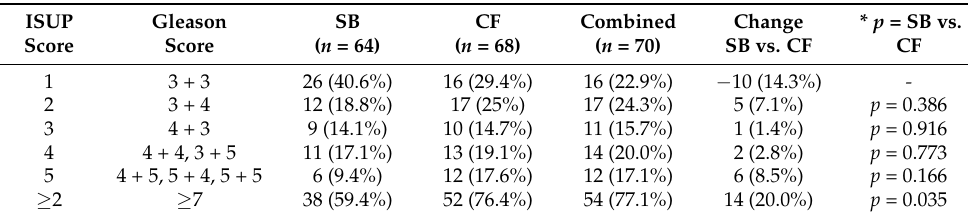
Table 1. Pathological ISUP and Gleason scores for patients diagnosed with prostate cancer in our study (number, percentage % of the specific group). CF = cognitive fusion biopsy, SB = systematic biopsy, Combined = combination between SB and CF methods. * chi-square test.